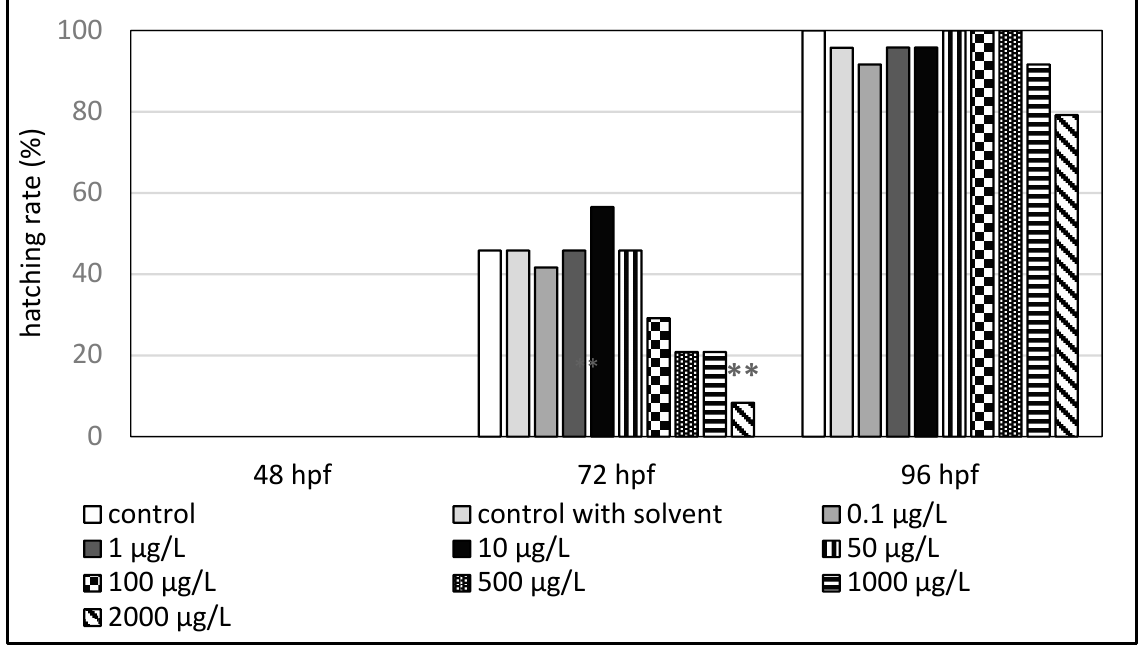
Figure 4. Hatching rate (%) of zebrafish embryos exposed to benzophenone-3 (hpf—hours post fertilization). The asterisk indicates a significant difference (** p < 0.01) between the control and experimental groups at the same time of exposure.